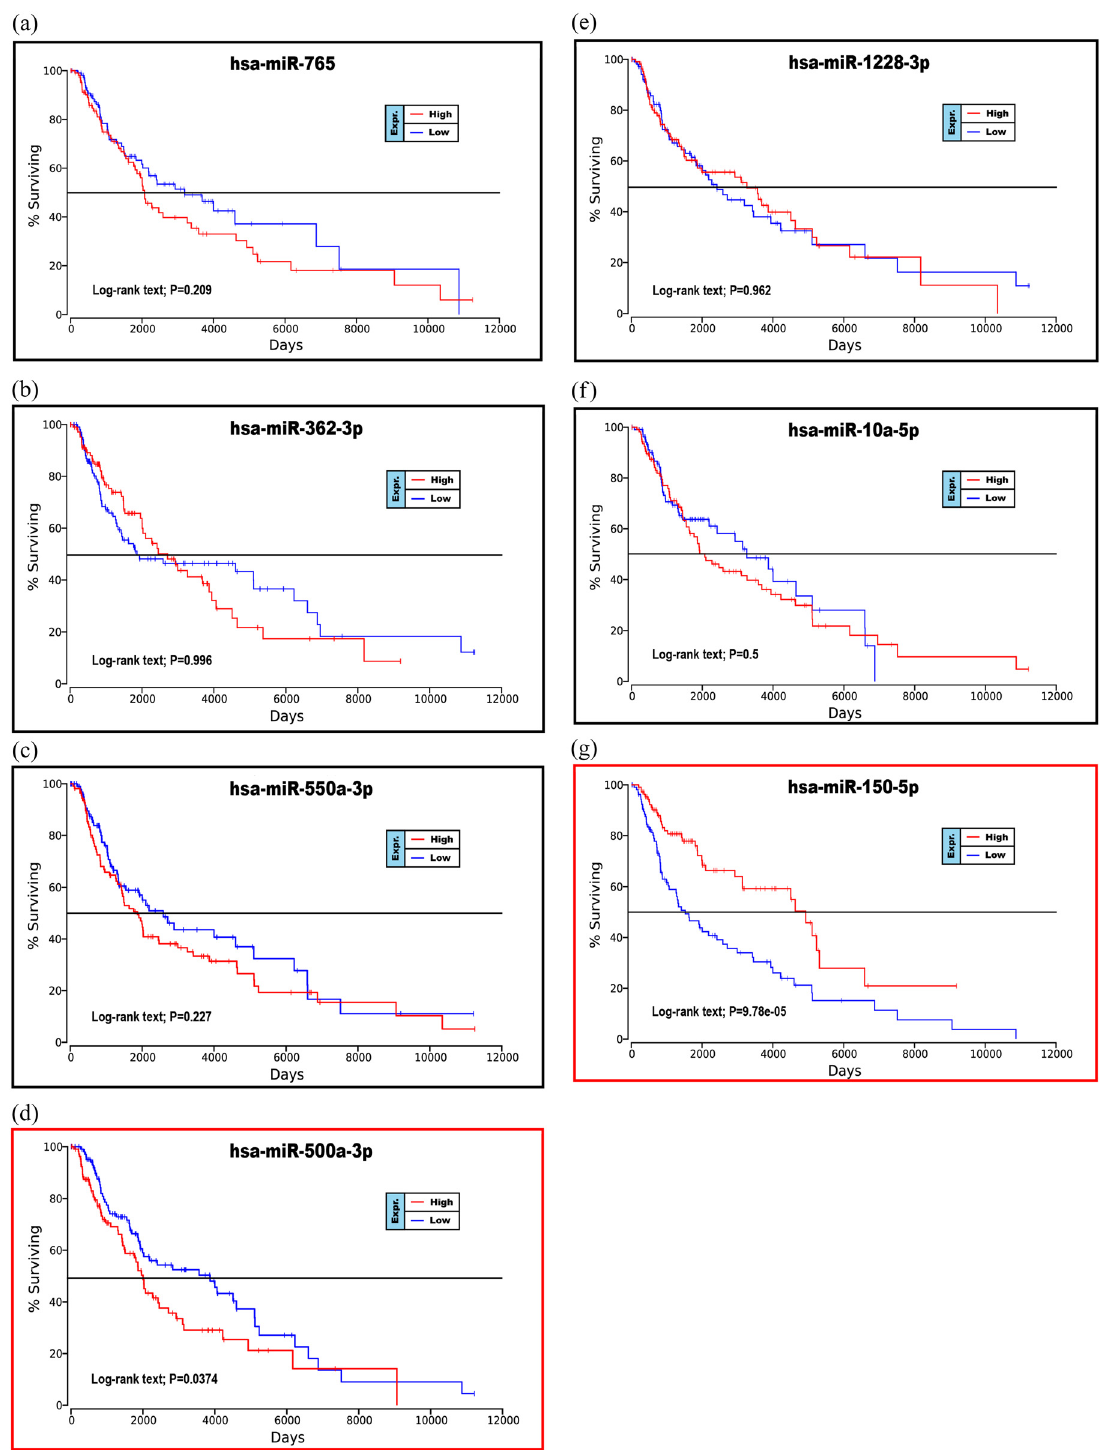
Figure 8: Prognostic analysis of the upregulated or downregulated DE - miRNAs with the OncoLnc database: ( a ) hsa - miR - 765, ( b ) hsa - miR - 362 - 3p, ( c ) hsa - miR - 550a - 3p, ( d ) hsa - miR - 500a - 3p, ( e ) hsa - miR - 1228 - 3p, ( f ) hsa - miR - 10a - 5p and ( g ) hsa - miR - 150 - 5p. P < 0.05 was considered statistically signi fi